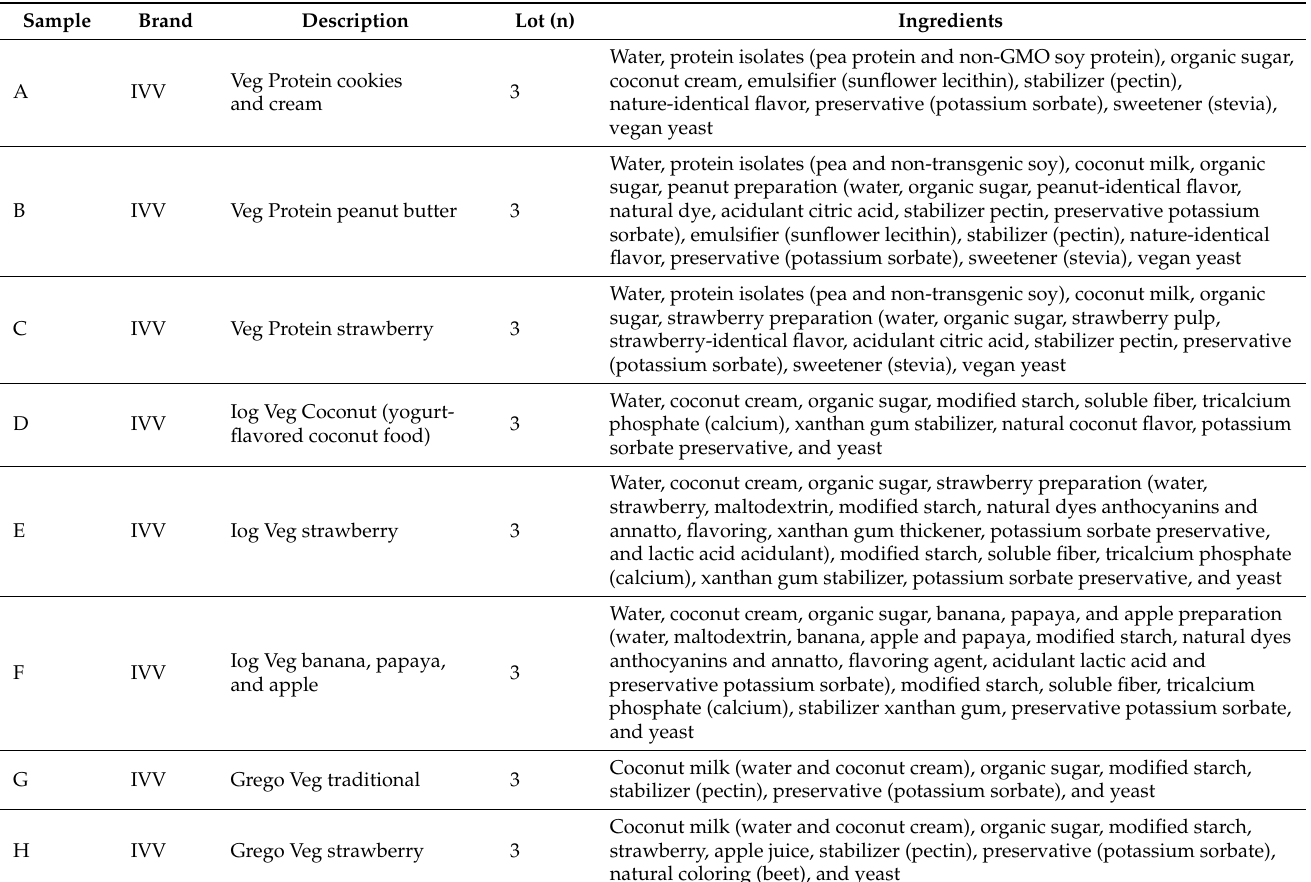
Table 2. Identification and labeling information (description and ingredients) of the plant-based and animal-based yogurt